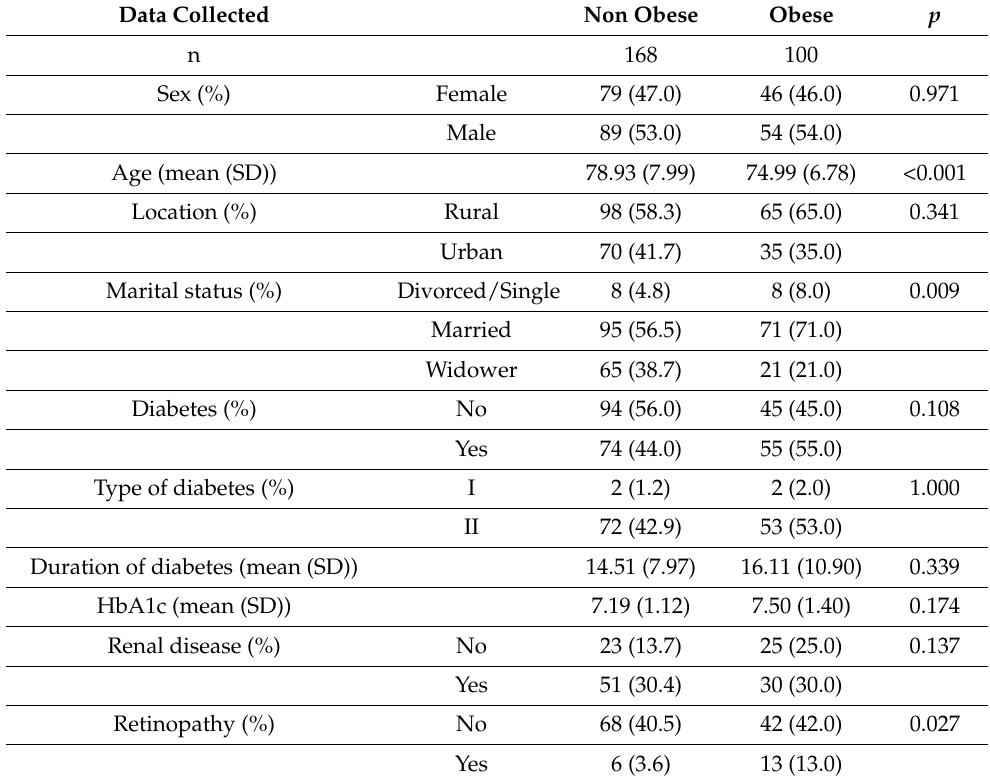
Table 2. Comparing the characteristics of obese and non-obese